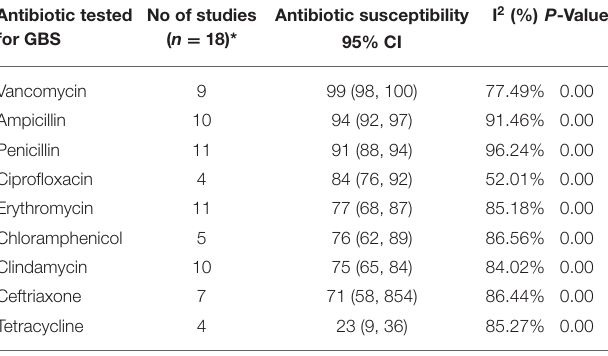
TABLE 3 | Pooled proportion of Antibiotic susceptibility of GBS isolated from pregnant women in Ethiopia since December 2012 to November 2021. Antibiotic tested for